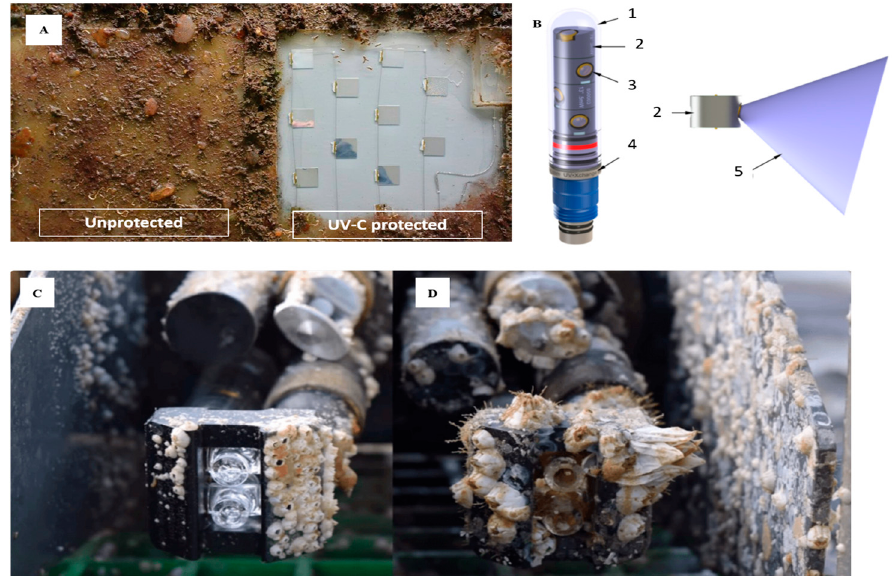
Figure 7. ( A ) Effectiveness of a UV-C irradiated panel versus the control panel against biofouling (RunWell-project, Royal Philips [108]). ( B ) UV Xchange major components [111]: ( 1 ) glass pressure case; ( 2 ) LED modules; ( 3 ) UV-LED; ( 4 ) titanium stem; ( 5 ) UV beam approximation in water (~70°). ( C ) UV-protected probe after nine months of deployment. ( D ) Non-UV-protected probe after nine months of deployment [109] (reproduced with permission of AML Oceanographic (and the permission of Royal Philips).